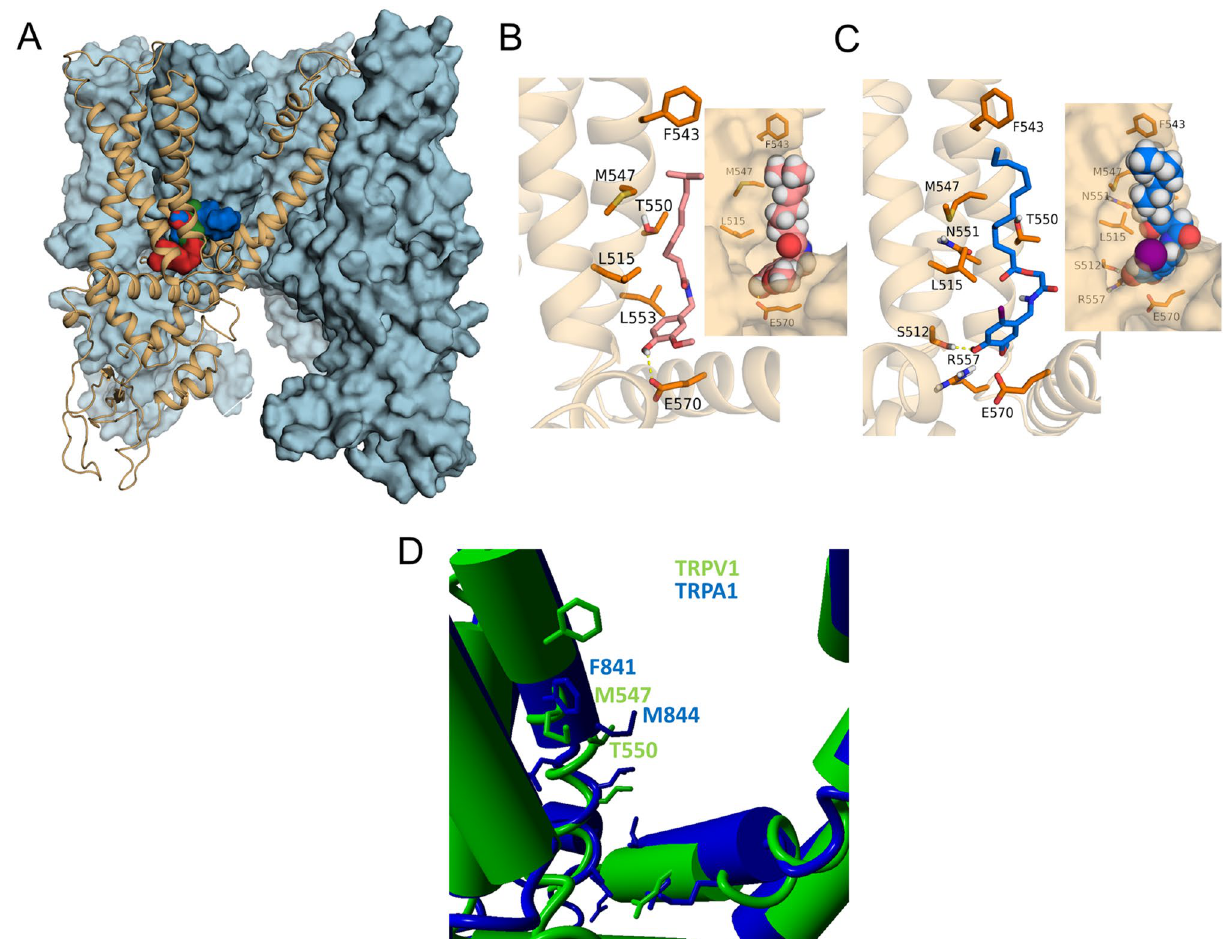
Figure 4. AG1529 binds to the capsaicin binding site in TRPV1. ( A ) Transmembrane view of rat TRPV1 structure with three subunits shown as blue surface and one as orange cartoon. For global blind docking assay capsaicin (red surface), capsazepine (green surface) and AG1529 (blue surface) displayed the same binding pocket which corresponds to the capsaicin binding site compressed between helices S3, S4 and the S4–S5 linker. ( B ) Capsaicin (reddish sticks) orientation in its binding site explored through local docking assay. VDW interactions are observed within capsaicin tail and residues L515 (S3), F543, M547, T550 and L553 (S4). Hydrogen bond is formed between capsaicin head and E570 from the S4-S5 linker. In the inset capsaicin is represented as spheres and the receptor as surface. ( C ) AG1529 (blue sticks) adopted the same orientation as capsaicin and displayed the same VDW interactions but formed a hydrogen bond with S512. In the inset AG1529 is represented as spheres, where the purple one stands for iodine group and receptor is shown as surface. It can be observed the conformation limitation the head of AG1529 experiments. ( D ) Structural view of the capsaicin binding pocket of TRPV1 (green) aligned with TRPA1 (blue). Notice that the M844 side chain of TRPA1 is oriented to the central binding cavity sterically perturbing the accessibility of this site to AG1529. Up to 82% of AG1529 docking trials in TRPA1